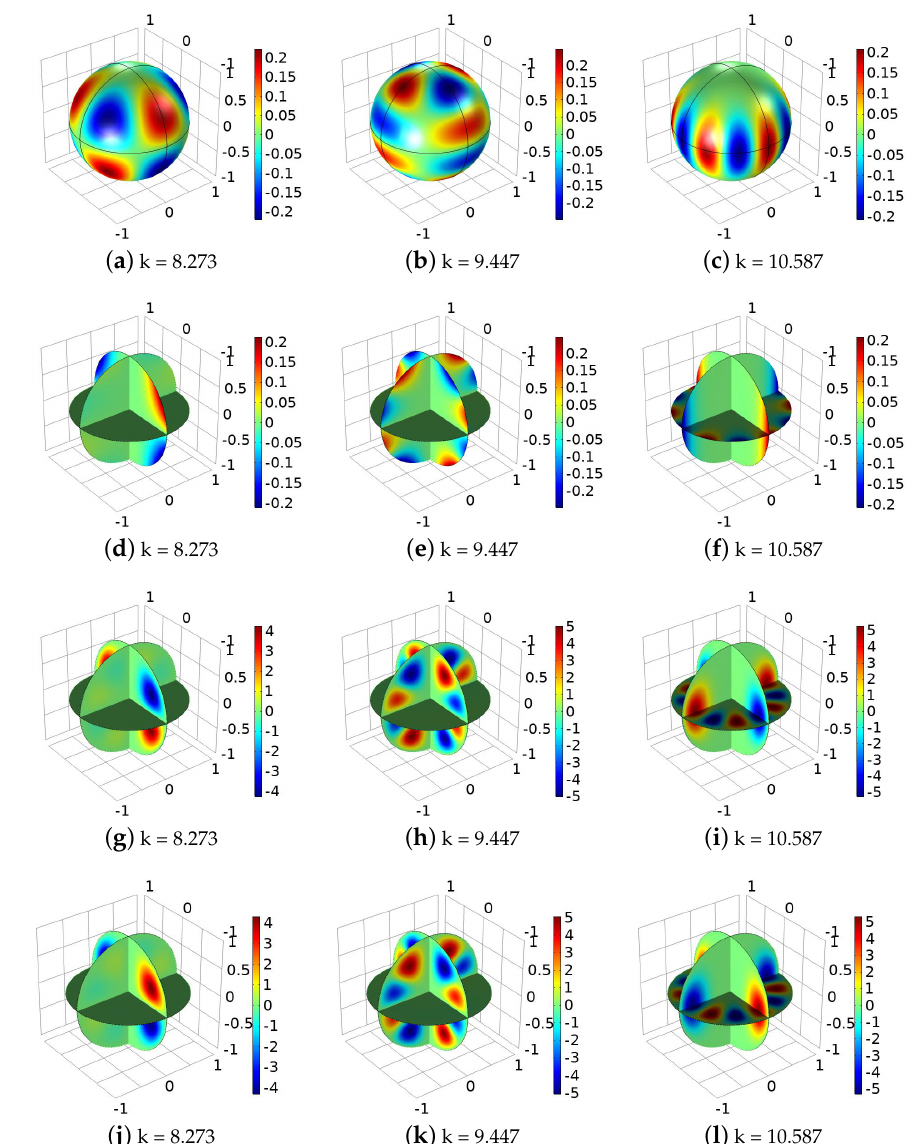
Figure 11. The magnitude of transmission eigenfunctions for a unit sphere with different k